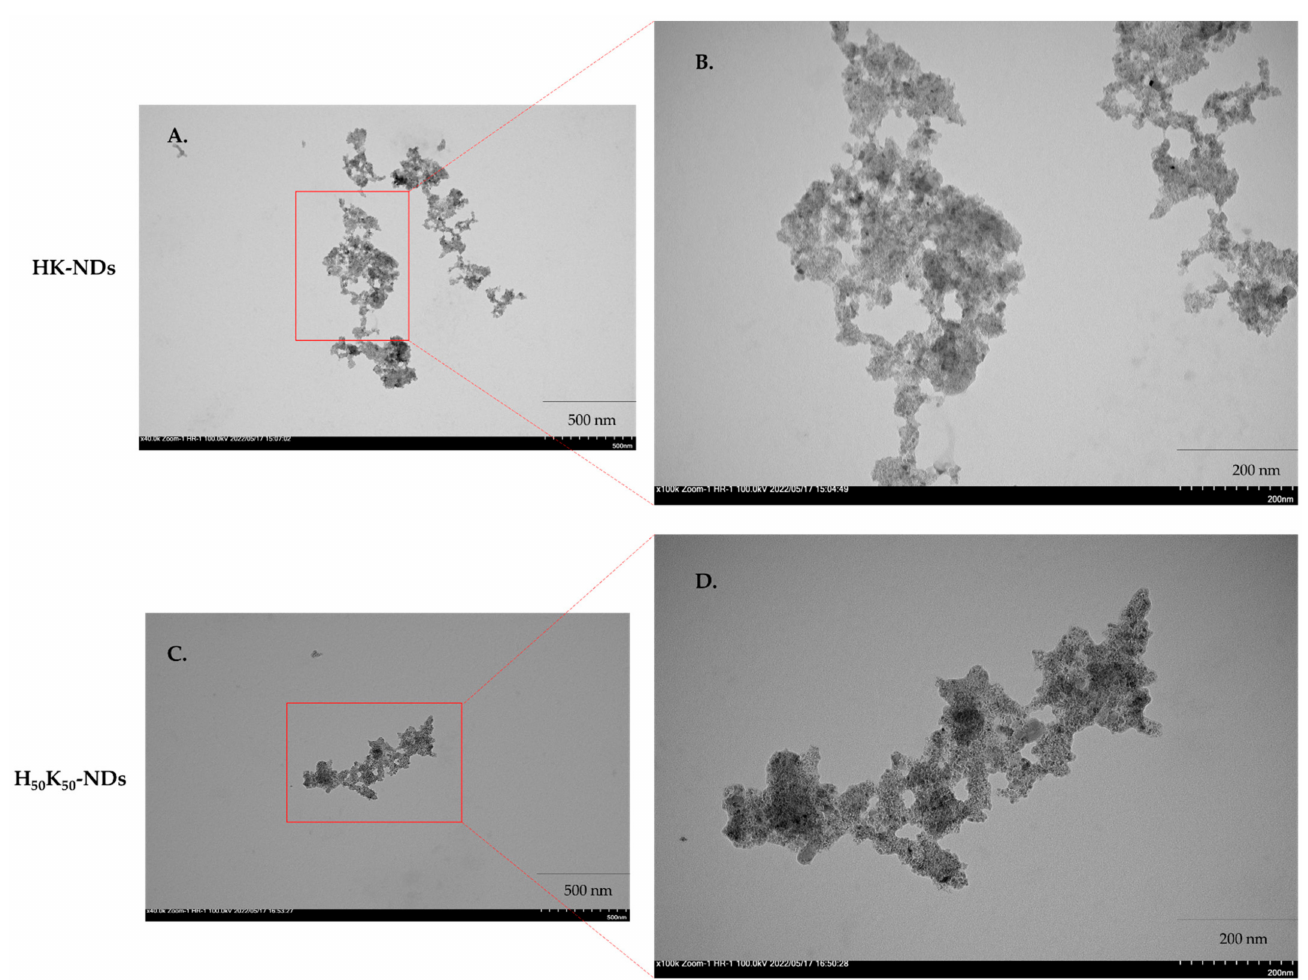
Figure 3. Electron micrographs of HK-NDs (top) and H 50 -K 50 -NDs (bottom) taken at 40,000 × magni- fication ( A , B ) and 100,000 × magnification ( C , D ). Bar on the lower right corner of the micrographs represent 500 nm ( A , B ) and 200 nm ( C , D ). Red boxes highlight portions of micrograph enlarged to show surface morphology of the clusters. Clear particle boundaries are visible for both HK-ND and H 50 K 50 -ND clusters. (HK-NDs = lysyl-histidine-NDs and H 50 K 50 -NDs =